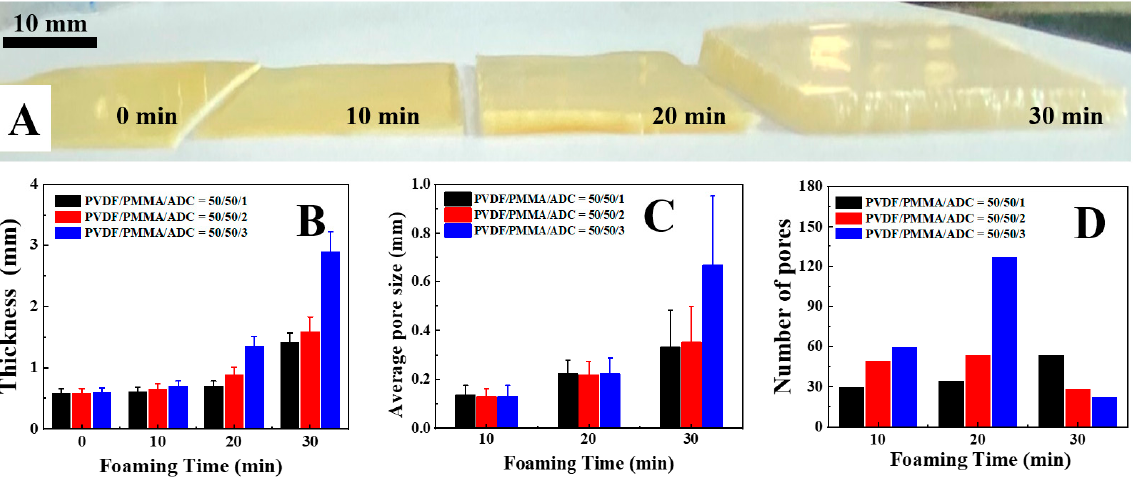
Figure 3. Photos ( A ) of a foamed PVDF/PMMA blend and its foaming time dependence on thickness ( B ), pore size ( C ) and pore number ( D ).